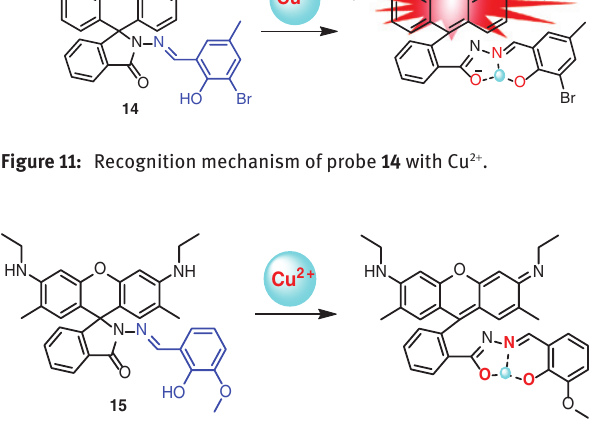
Figure 12: Recognition mechanism of probe 15 with Cu 2 + .